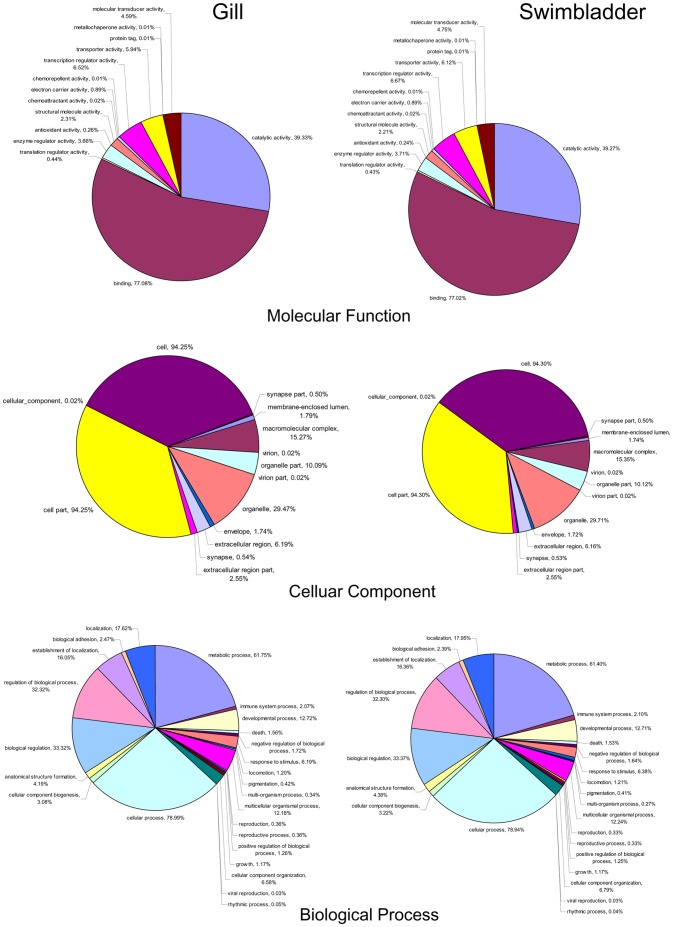
Gene Ontology (GO) (level 2) for the gill and swimbladder transcriptome under Molecular function, Cellular component and Biological process.